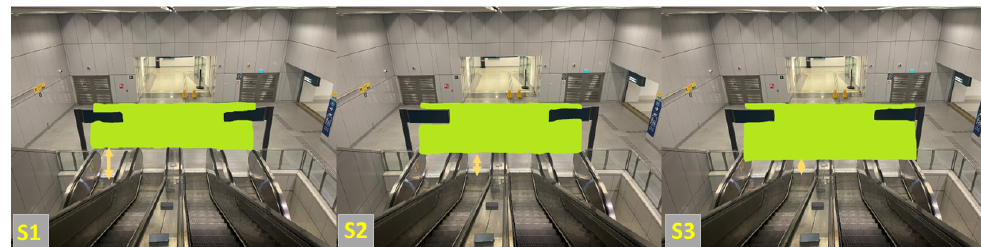
Figure 14. Generated track map after each trail from various starting points (S1 starting point 1, S2 starting point 2, and S3 starting point 3) near escalator of scenario-2 descending direction wherein the green pixels represents the robot-covered region, and yellow arrow represents the distance between the covered region and escalator’s first